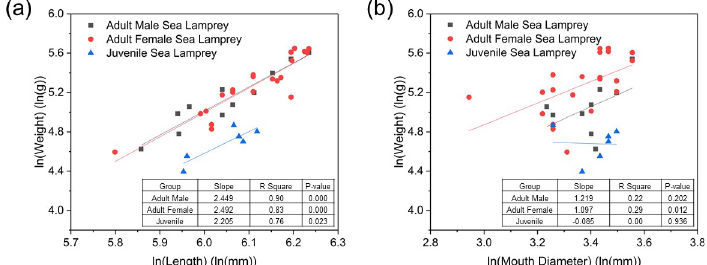
Fig 5. Relations between (a) ln(weight) and ln(length), and (b) ln(weight) and ln(mouth diameter) for tested adult male, female and juvenile sea